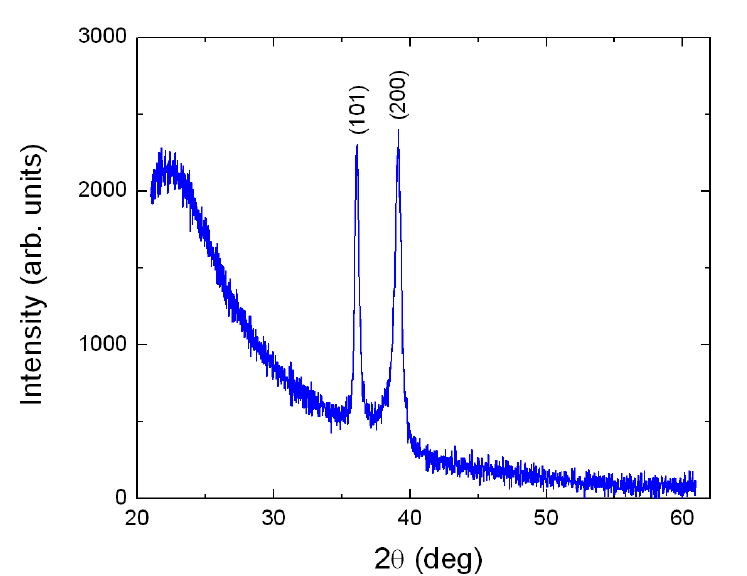
Figure 1. X-ray diffraction pattern of a Ti film grown on quartz glass after annealing for two hours at 600 ◦ C in a furnace under air atmosphere. Pure rutile 400 nm thick was formed. All XRD peaks are identified with the help of JCPDS Card No. 21-1276 (Joint Committee on Powder Diffraction Standards, International Center for Diffraction Data) for pure polycrystalline rutile.